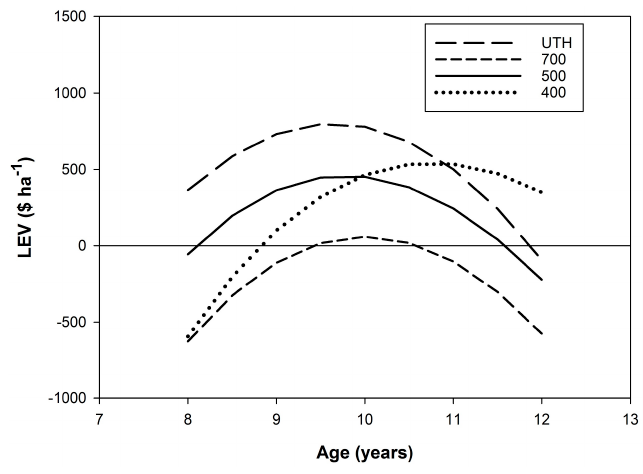
Figure 5. Land expectation values (LEVs) by stocking treatment.